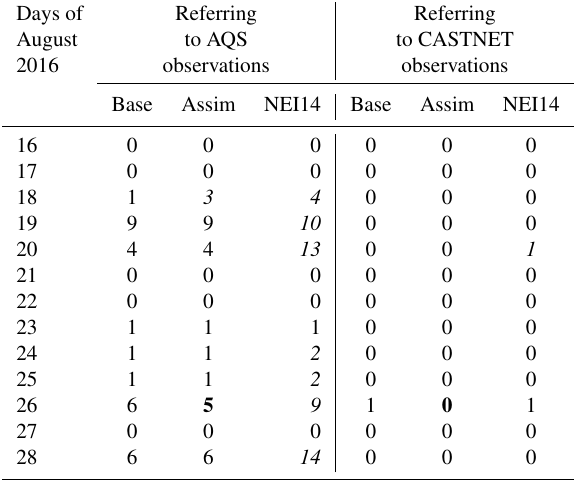
Table 3. The number of model grids with surface MDA8 O 3 ex- ceedance false alarms (i.e., the modeled MDA8 O 3 > 70ppbv but the observed MDA8 O 3 ≤ 70ppbv) from three 12km simulations which are defined in Table 1. Degradations and improvements from the base case are highlighted in italics and bold,